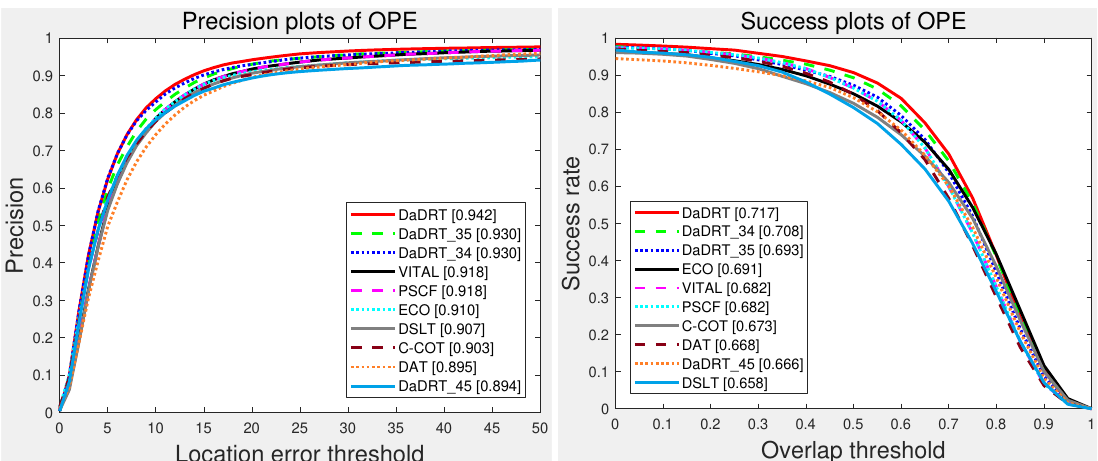
Figure 10. Ablation-study results on the OTB-15 dataset using one-pass evaluation. The numbers in the legend indicate the average distance-precision scores at 20 pixels and the area-under-curve success scores, respectively. Results are best viewed on high-resolution displays.